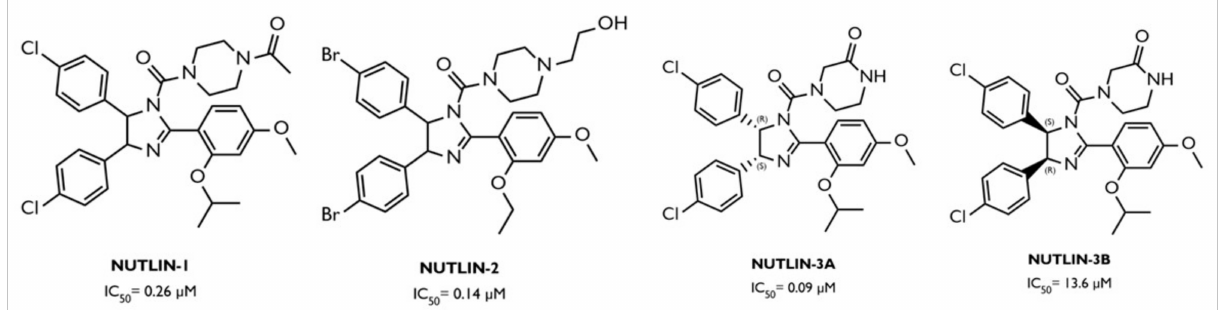
Figure 6. Nutlins. Chemical structures of the different compounds of the nutlins family, with the respective IC 50 values, resulting from the inhibition of MDM2